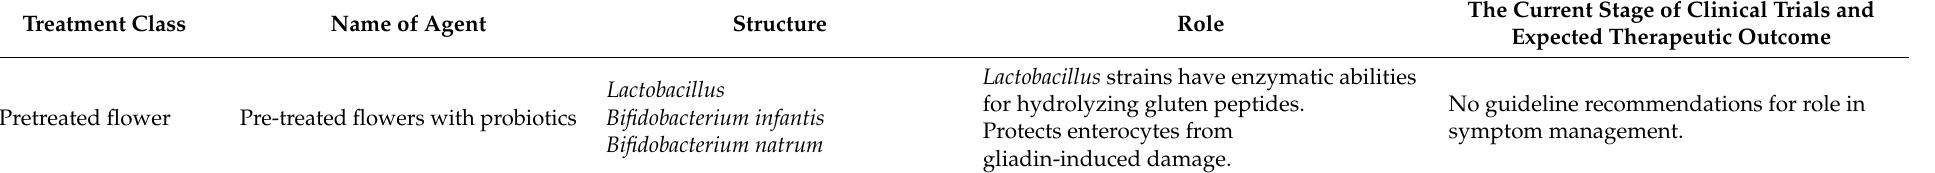
Table 2. Short description of emerging new drugs for CD patients, their structure, role, and partial results from clinical